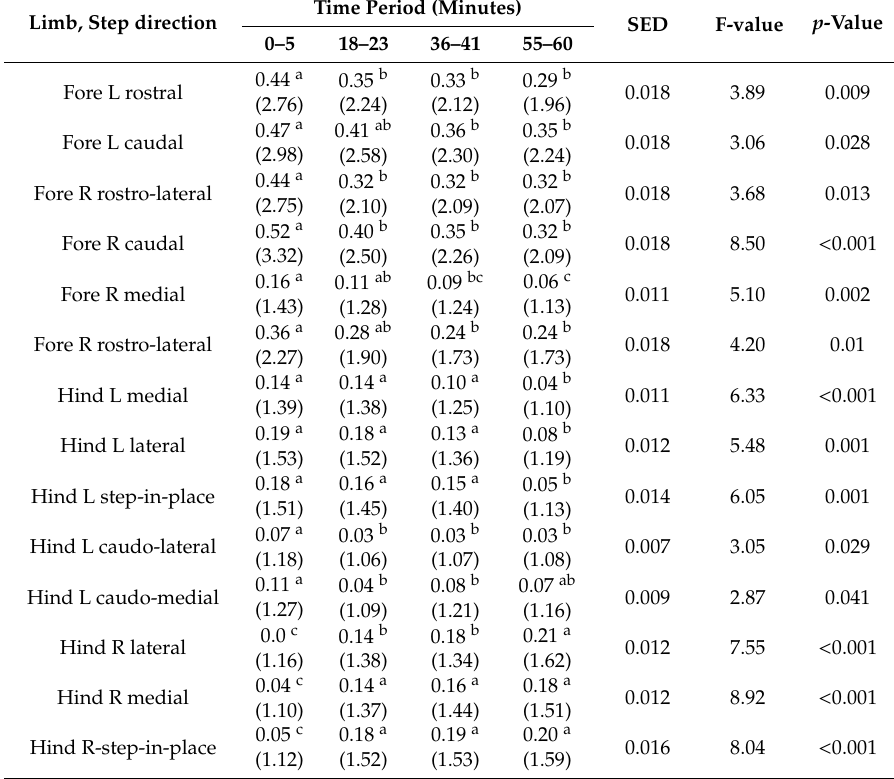
Table A5. E ff ects of time within the hour’s exposure on the stepping responses of the four limbs of sheep ( n = 6) subjected to motion treatments and a control. Data presented as (log 10 + 1) steps / 20 min, with back-transformed means provided in brackets. Comparisons with significantly di ff erent counts of stepping responses are presented, with these data also presented graphically in Figure 5. (L = left and R =